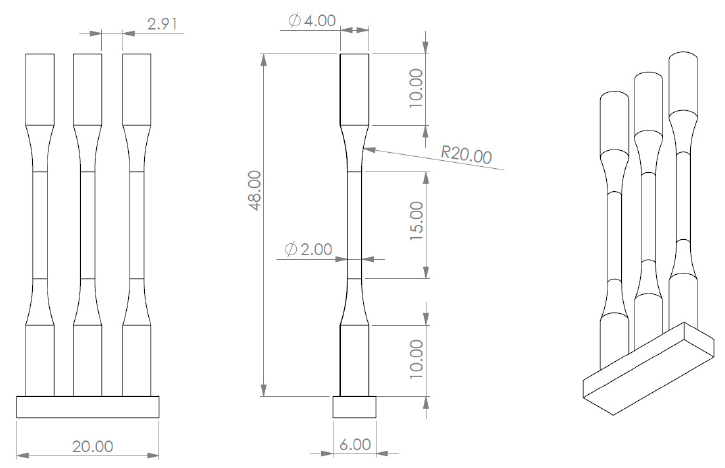
Figure 3. Technical drawing of the round tensile bars to determine Young’s modulus.